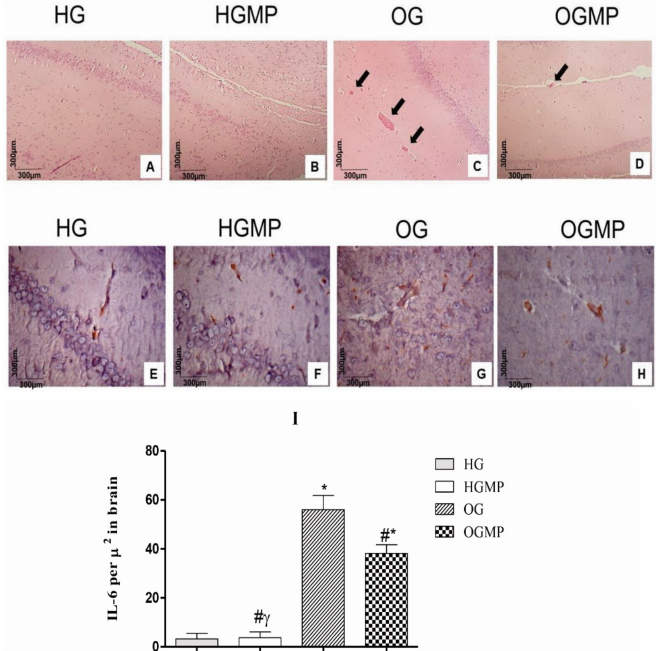
Figure 6. Histology ( A – D ), immunohistochemical ( E – I ) analysis of the hippocampus of healthy and obese rats treated or not with MP. The arrow indicates dilated vessels. Data presented as mean and standard deviation of the mean. Two-way ANOVA, p ≤ 0.05 Tukey’s post hoc test. * di ff ered from HG; # di ff ered from OG; γ di ff ered from